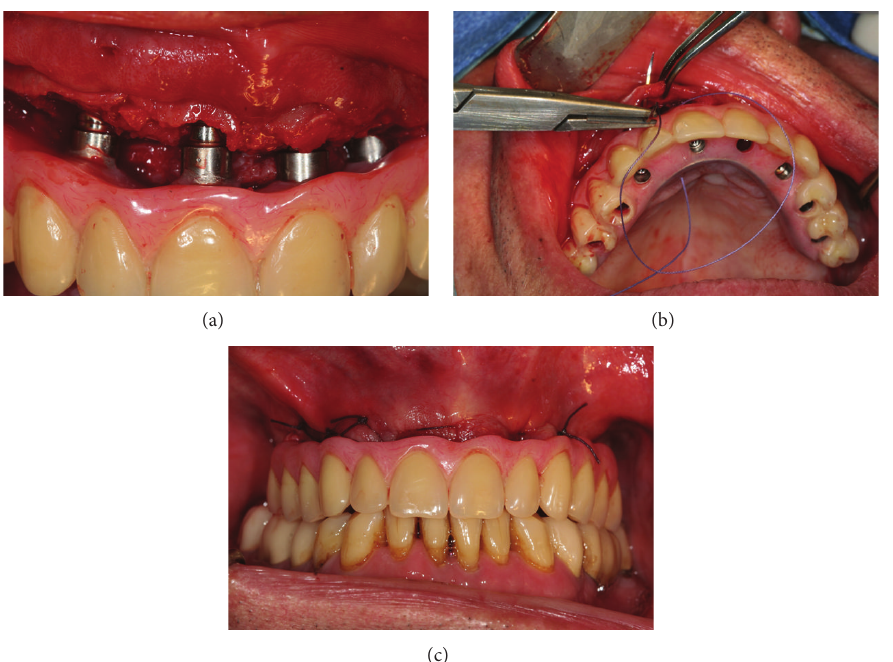
Figure 6: (a) Insertion of the restoration, in this protocol and because of the flap, the correct seating of the prosthesis can be checked visually. (b) The flap is sutured after the correct insertion of the restoration. (c) Final intraoral view.